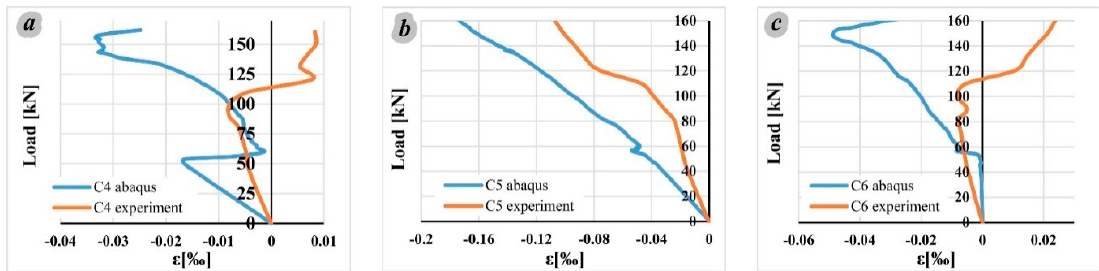
Figure 27. Experimental and numerical (model FEM B) strains of member W3 in gauges: ( a ) C4, ( b ) C5, and ( c ) C6.